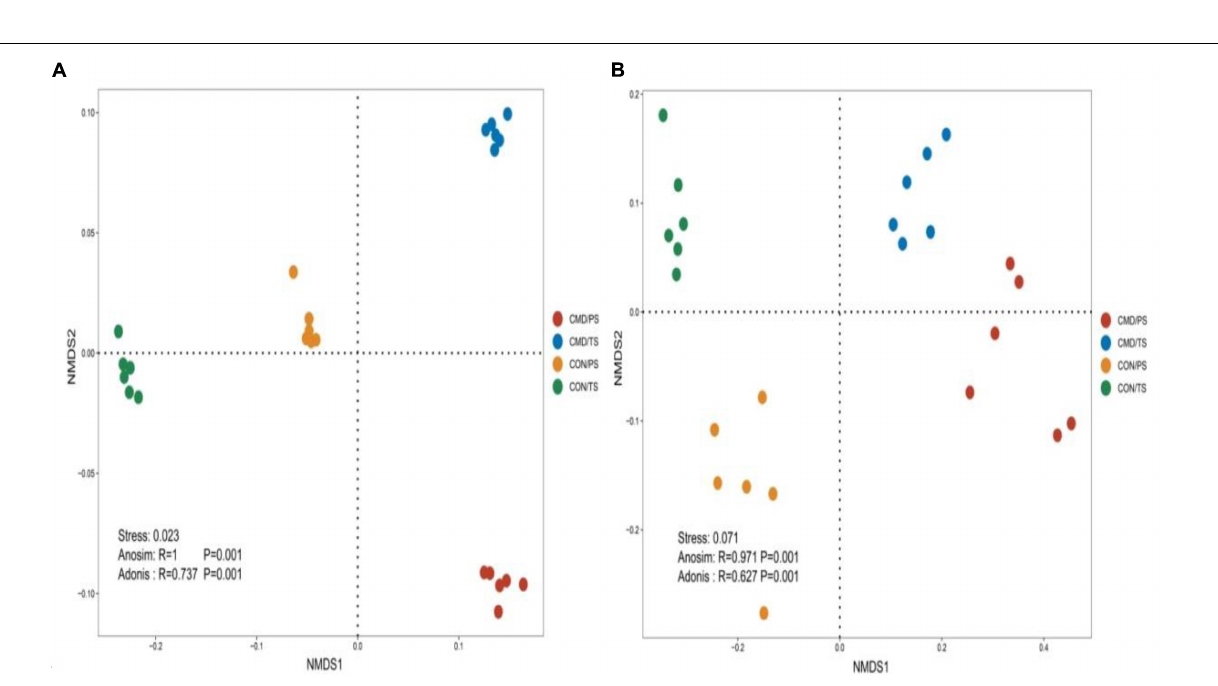
Frontiers in Microbiology |